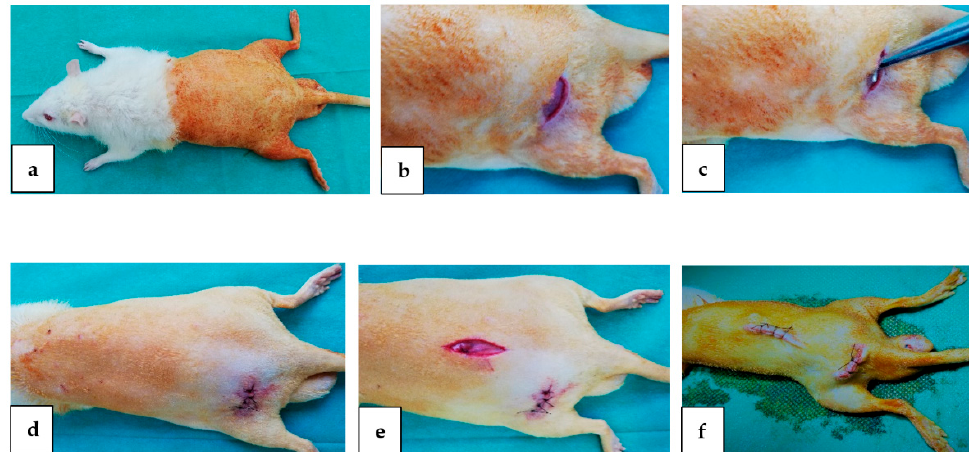
Figure 1. Surgical procedure used to implant metallic samples: ( a )—preoperative aspect; ( b )—the incision of the skin and the exposure of the femur; ( c )—fixing the piece next the femur; ( d )—skin suture; ( e )—fixing the piece in the lumbar area; ( f )—post-operatory appearance. The subjects were euthanized at 1, 2, 4, and 8 weeks after surgery, and the left thigh SEM exam samples were fixed in 2% glutaraldehyde phosphate buffer, dehydrated in and lumbar vertebrae were collected with magnesium alloy rods for histological exami- nation. Femoral tissue samples were fixed in 10% buffered formalin for 24 h, desalted with 5% trichloroacetic acid solution for 4 days, and embedded in paraffin after stereotyping.